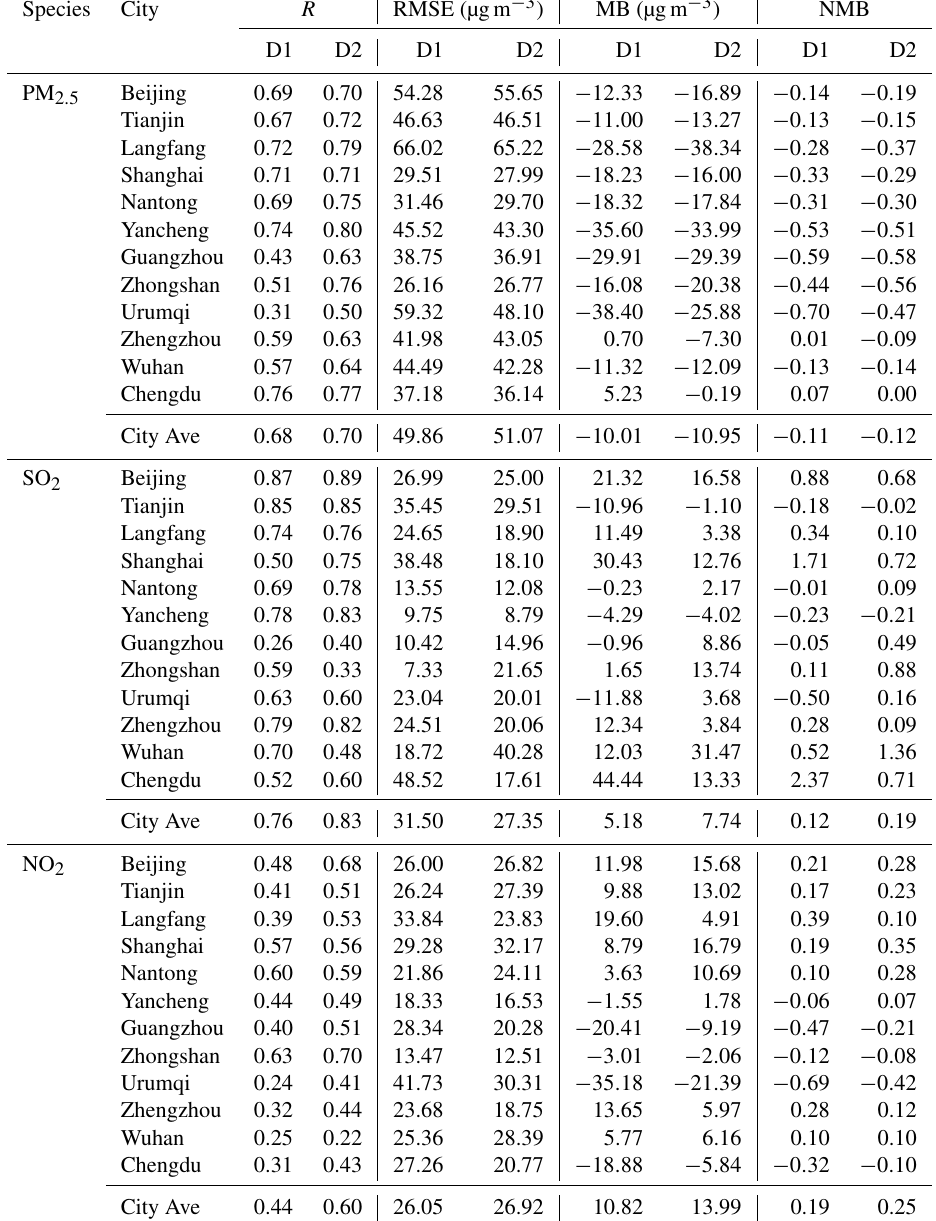
Table 6. Summary of the statistics for the global and nested domains. D1 and D2 represent the results for domain 1 and domain 2 respectively. “City Ave” refers to the average of all